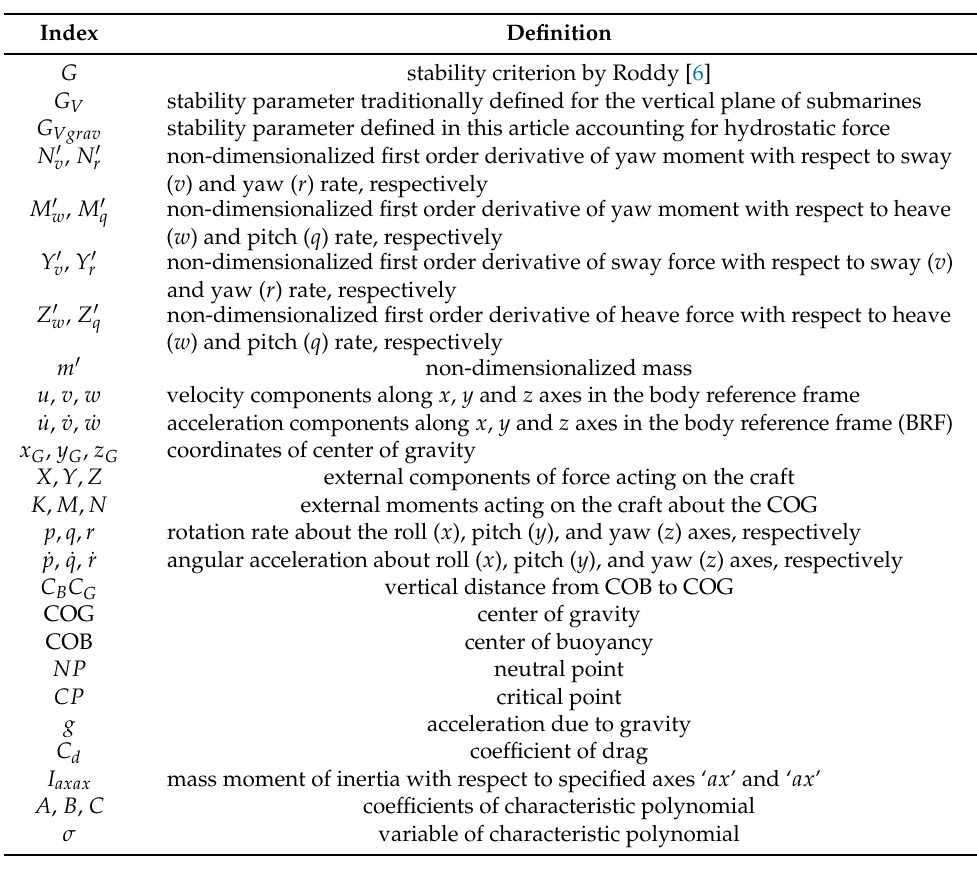
Table 1. Definitions of various symbols and abbreviations used in this